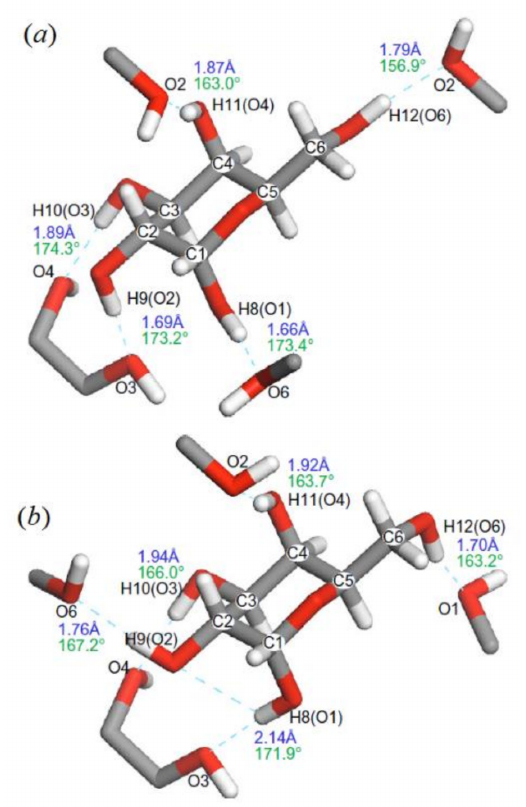
Figure 17. α -D-galactose with hydrogen atom positions optimized with the PBE exchange-correlation functional: ( a )—Kouwijzer’s model (Model A) and ( b )—Sheldrick’s model (Model B). The hydrogen bond networks are shown by dashed lines with calculated bond length (blue) and O–H ··· O bond angles (green). Reproduced from Kibalchenko et al. [118] with the permission of